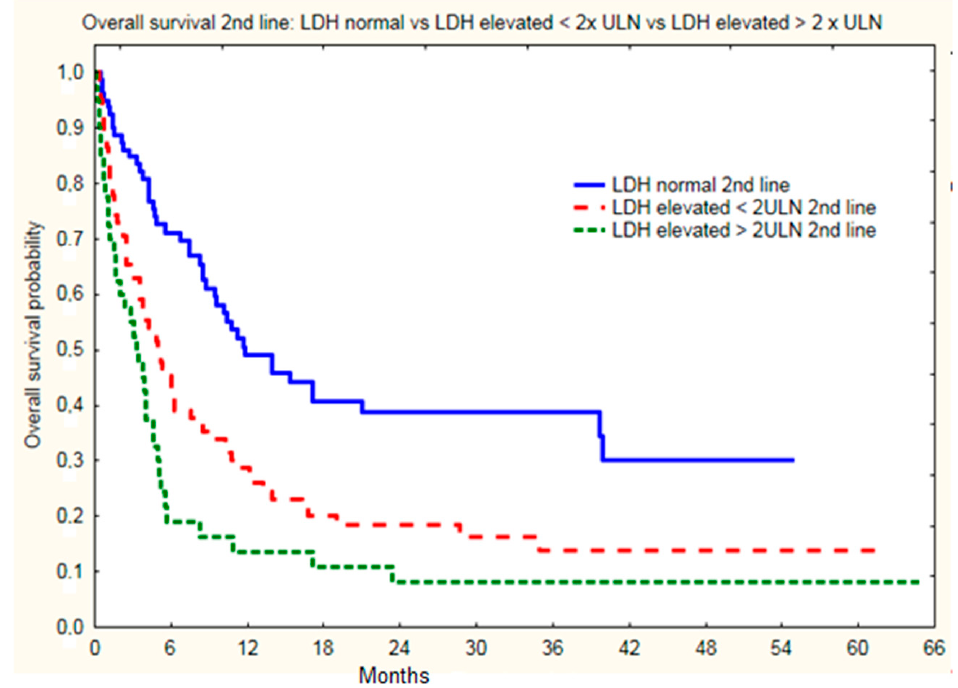
Figure 6. Overall survival of melanoma patients with normal and elevated LDH level since initiation of second line immunotherapy.